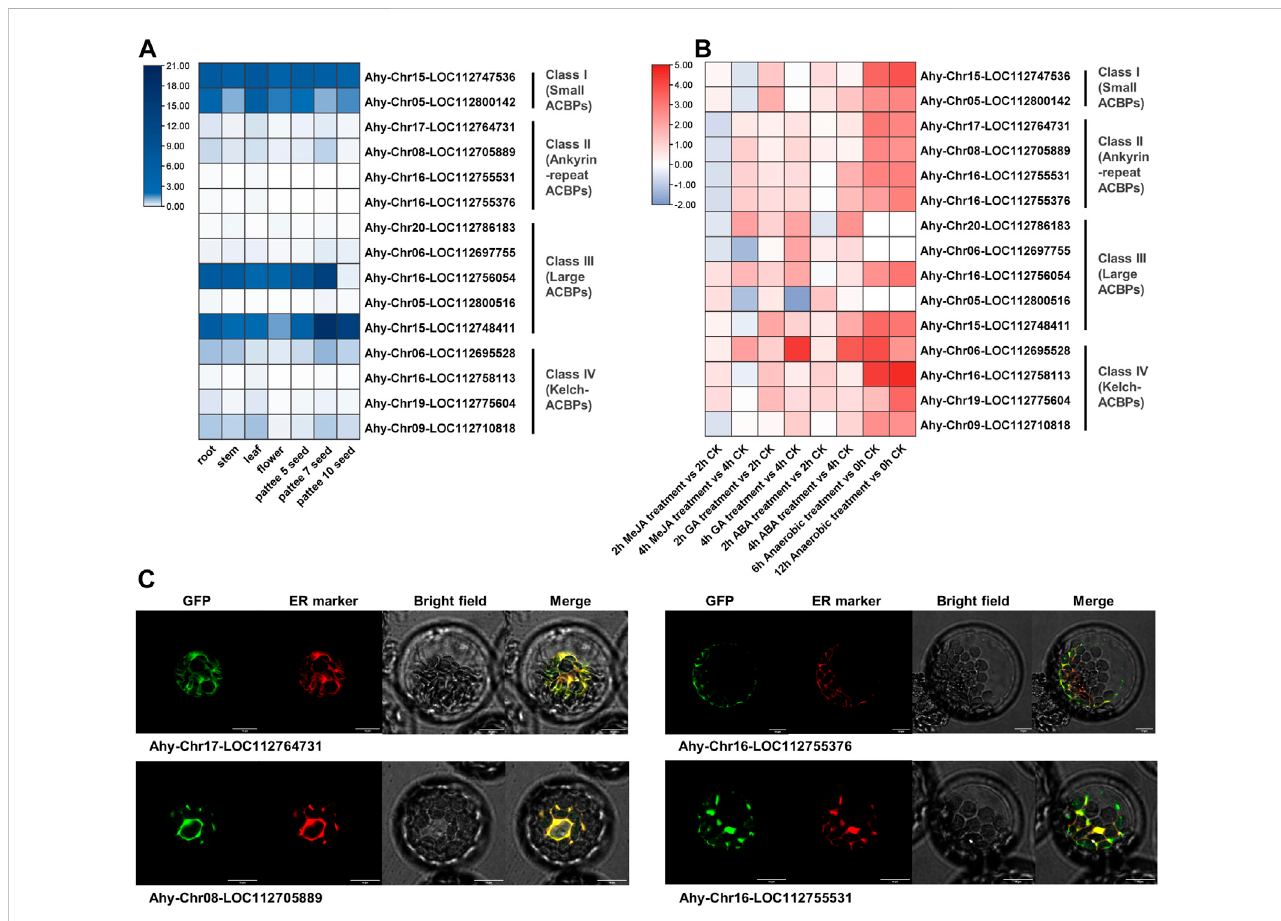
FIGURE 6 Expression pro fi les, exogenous stimulus response and subcellular localization of Arachis hypogaea ACBPs. (A) The expression pro fi les of Arachis hypogaea ACBPs. The color scale bar ranging from white to blue represents low and high expression level, respectively. The seven tissues used in the expressionpro fi lesofAhACBPsgeneswereasfollowing:root,stem,andleafcamefrom30daysseedling;seedswerecollectedat3developmentalstages. (B) The response of Arachis hypogaea ACBPs to exogenous stimuli. The heat map was constructed using the log 2 -transformed relative expression levels. The experimental material came from 30 days seedling leaf after treatment. The color scale bar ranging from blue to red represents inhibit and promote expression compared to CK (Control Check). MeJA, Methyl ester Jasmonic Acid; GA, Gibberellin; ABA, Abscisic Acid. (C) Subcellular localization of Arachis hypogaea ACBPs. Arachis hypogaea class II ACBPs of GFP fusions transiently expressed in Arabidopsis protoplasts and co-expressed with ER marker (Nelson et al., 2007). Bars, 10 μ